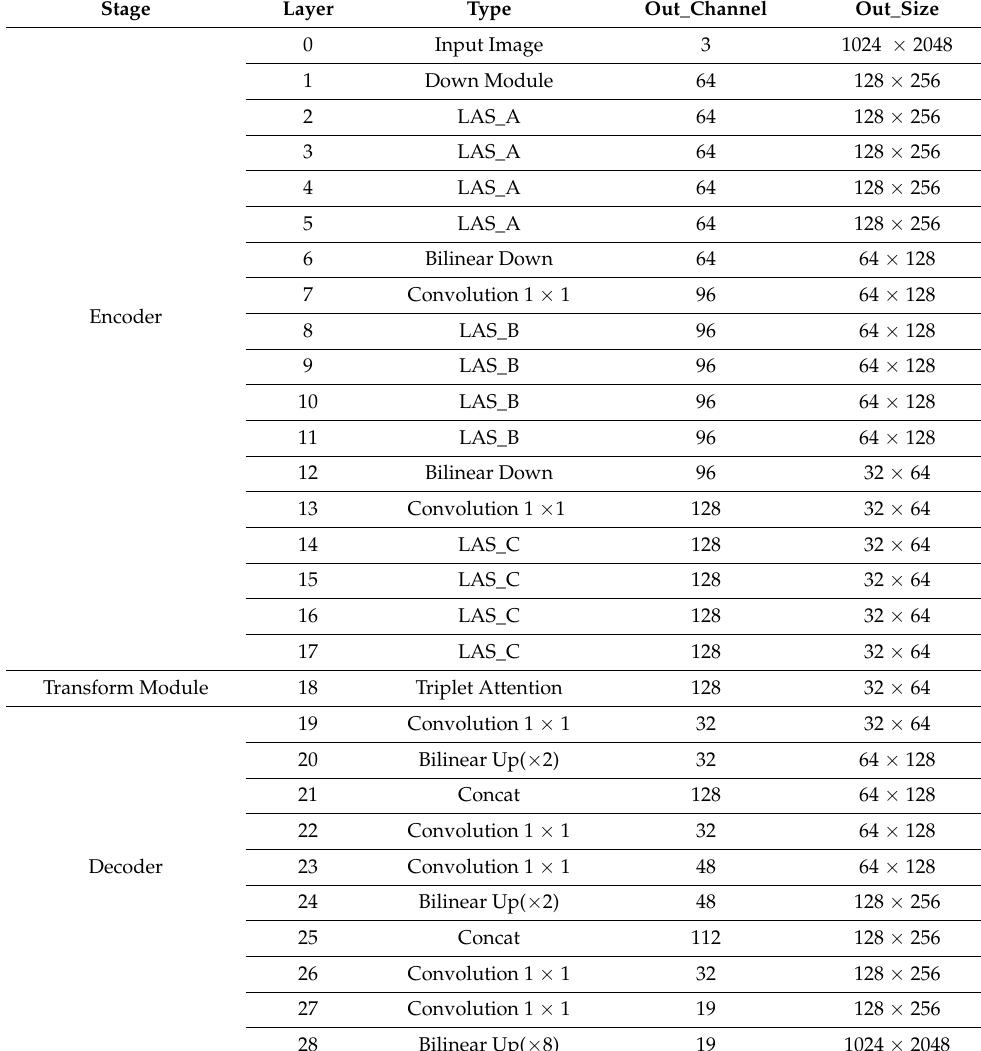
Table 1. Detailed architecture of proposed